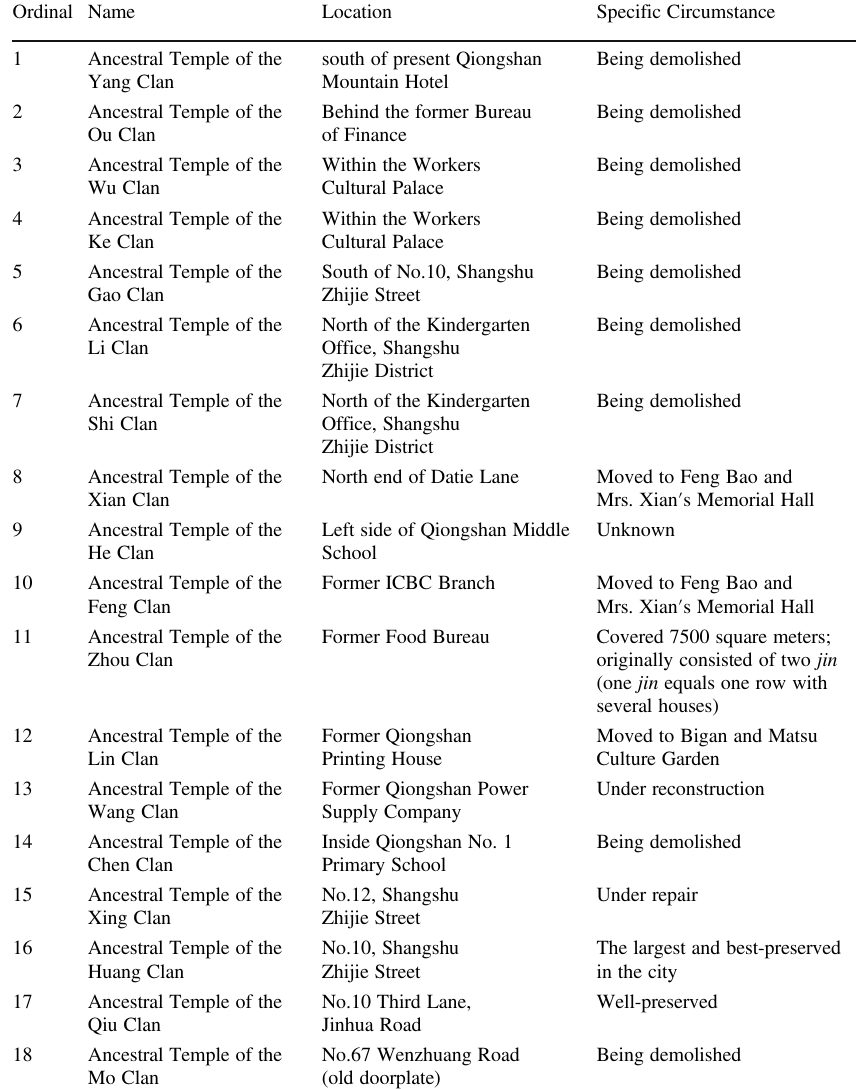
Table 1 Historical Ancestral Temples on Wenzhuang Road,